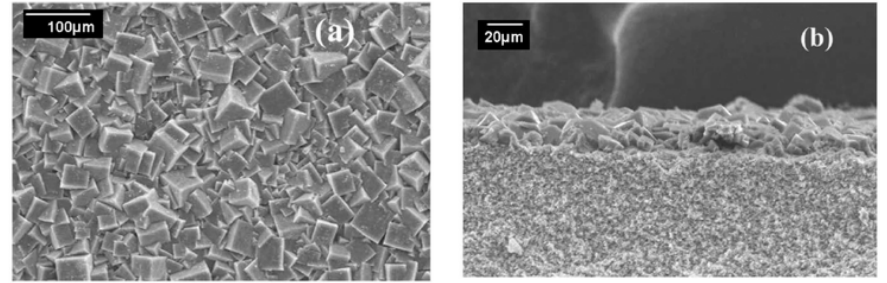
Figure 3. SEM images of the MOF-5 membrane: ( a ) top view; and, ( b ) cross-section (adapted with permission from ref. [56]).